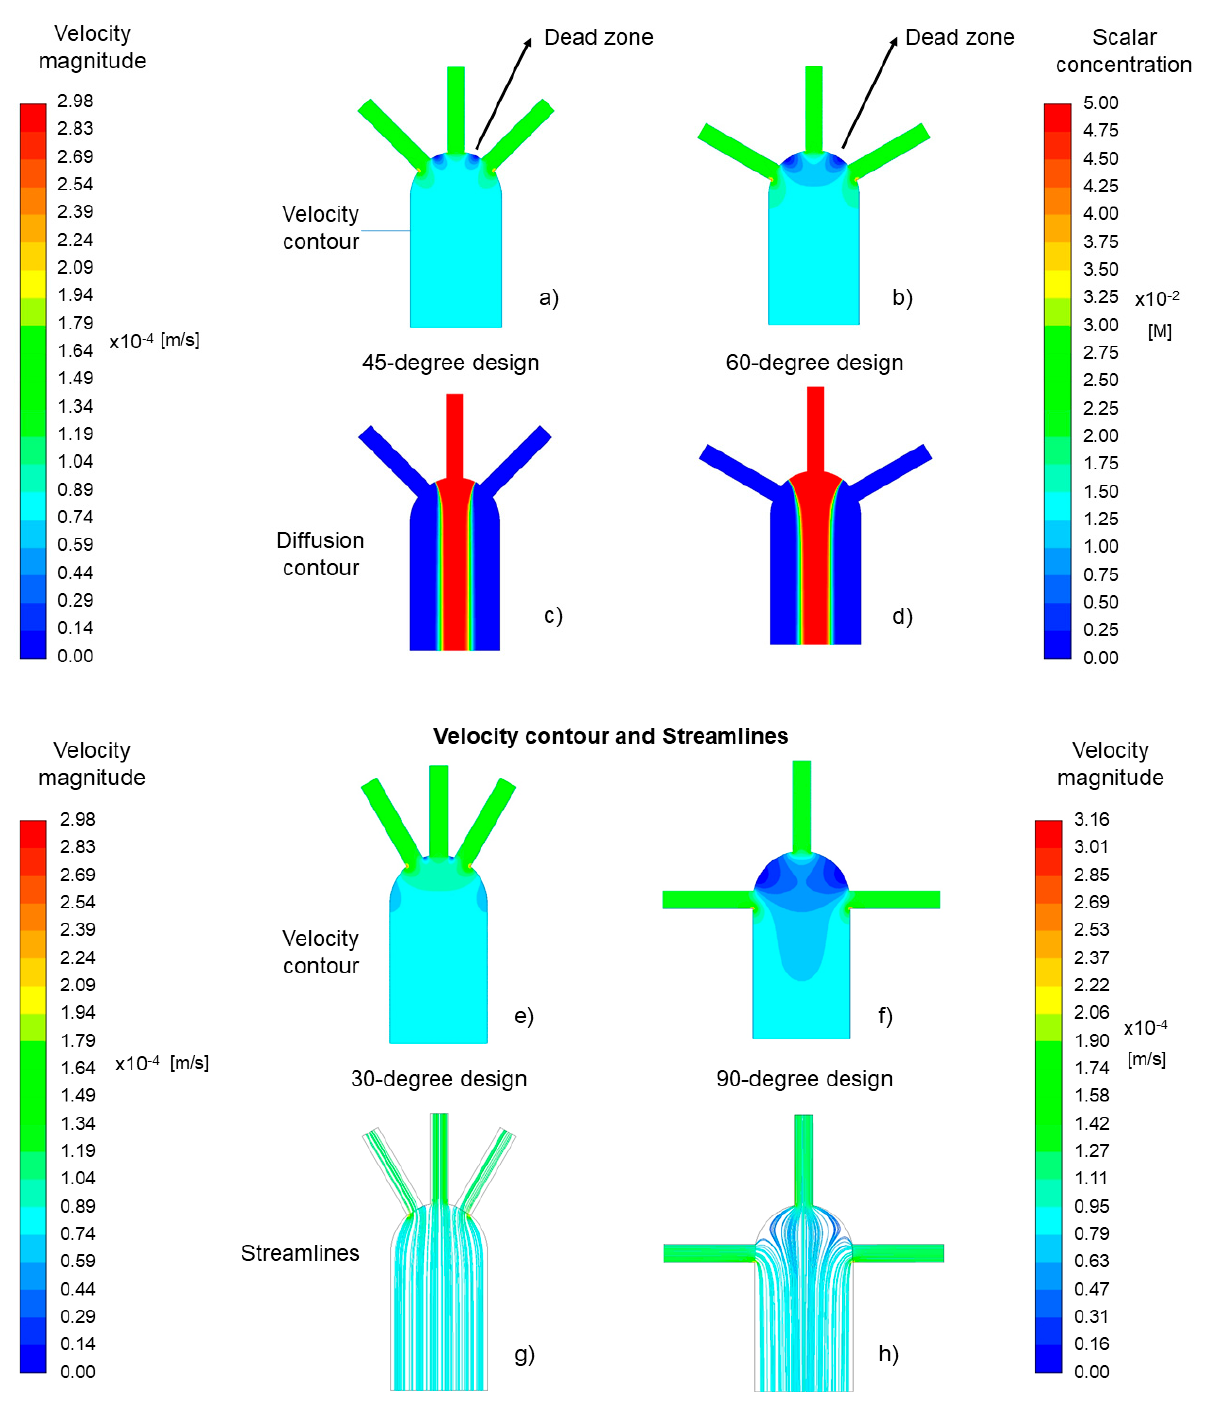
Figure 6. Velocity and diffusion contours of the 45-degree ( a , c ) and 60-degree designs ( b , d ). Velocity contours and streamlines of the 30-degree model ( e , g ) and the 90-degree model ( f , h ) are also illustrated.